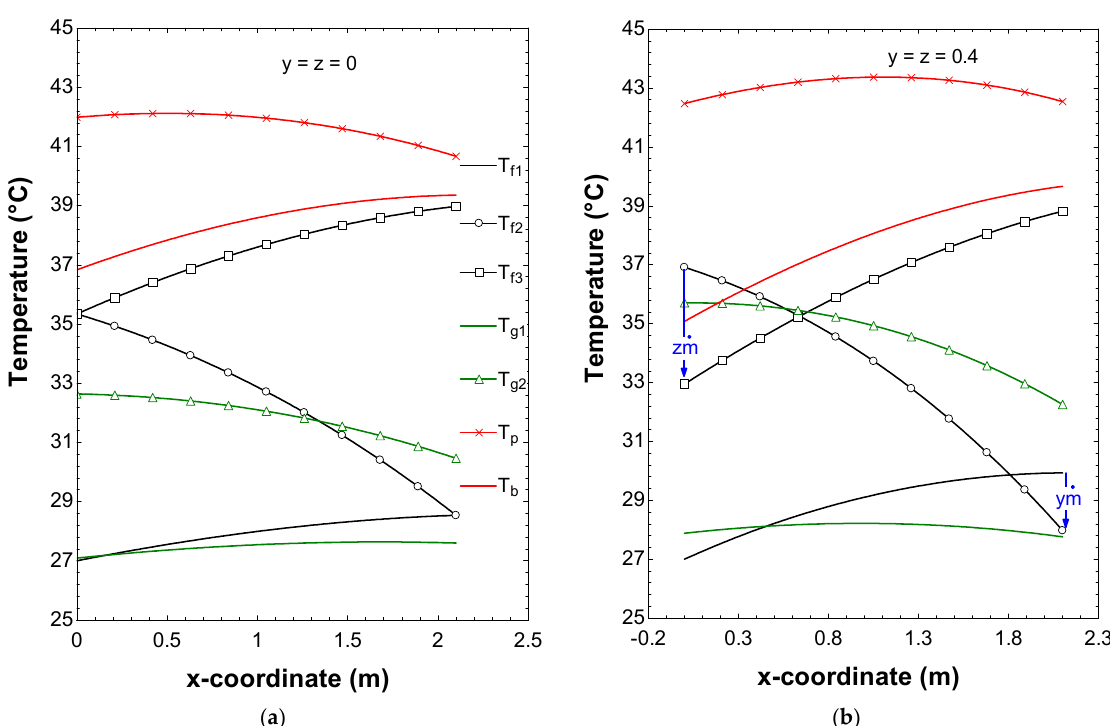
Figure 5. Local temperature of airflow in three passes, i.e., glass covers, absorber plate, and back plate at Re 3 = 10,000: ( a ) y = z = 0 (base case) and ( b ) y = z = 0.4.